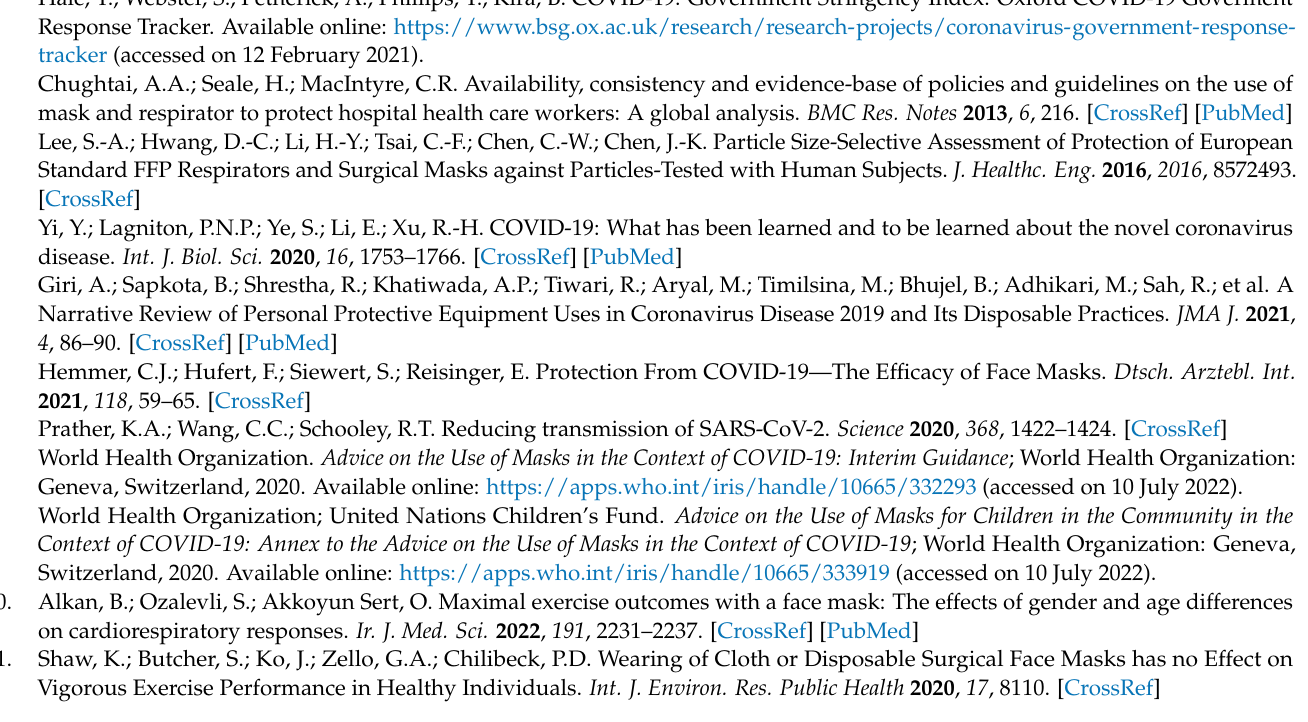
Table S11: Detailed 7-day incidences for detected SARS-CoV-2 infections for P4 (22 March and 22 April); Table S12: Potential SARS-CoV-2 infection in school classes GB vs. SF classes, using hypothesized generation time—2 days; Table S13: Potential SARS-CoV-2 infection in school classes GB vs. SF classes, using hypothesized generation time—4 days; Table S14: Potential SARS-CoV-2 infection in school classes GB vs. SF classes, using hypothesized generation time—6 days; Table